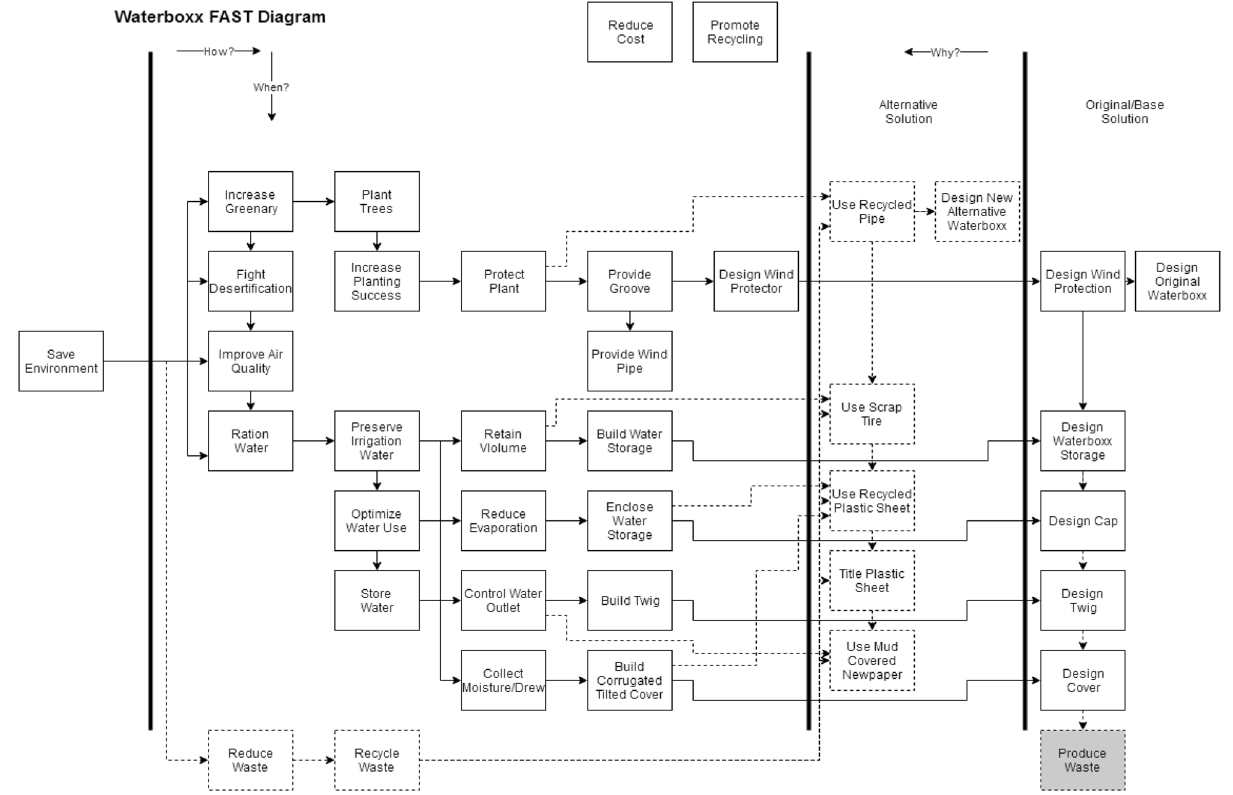
Figure 4. The constructed FAST Diagram of the WaterBoxx